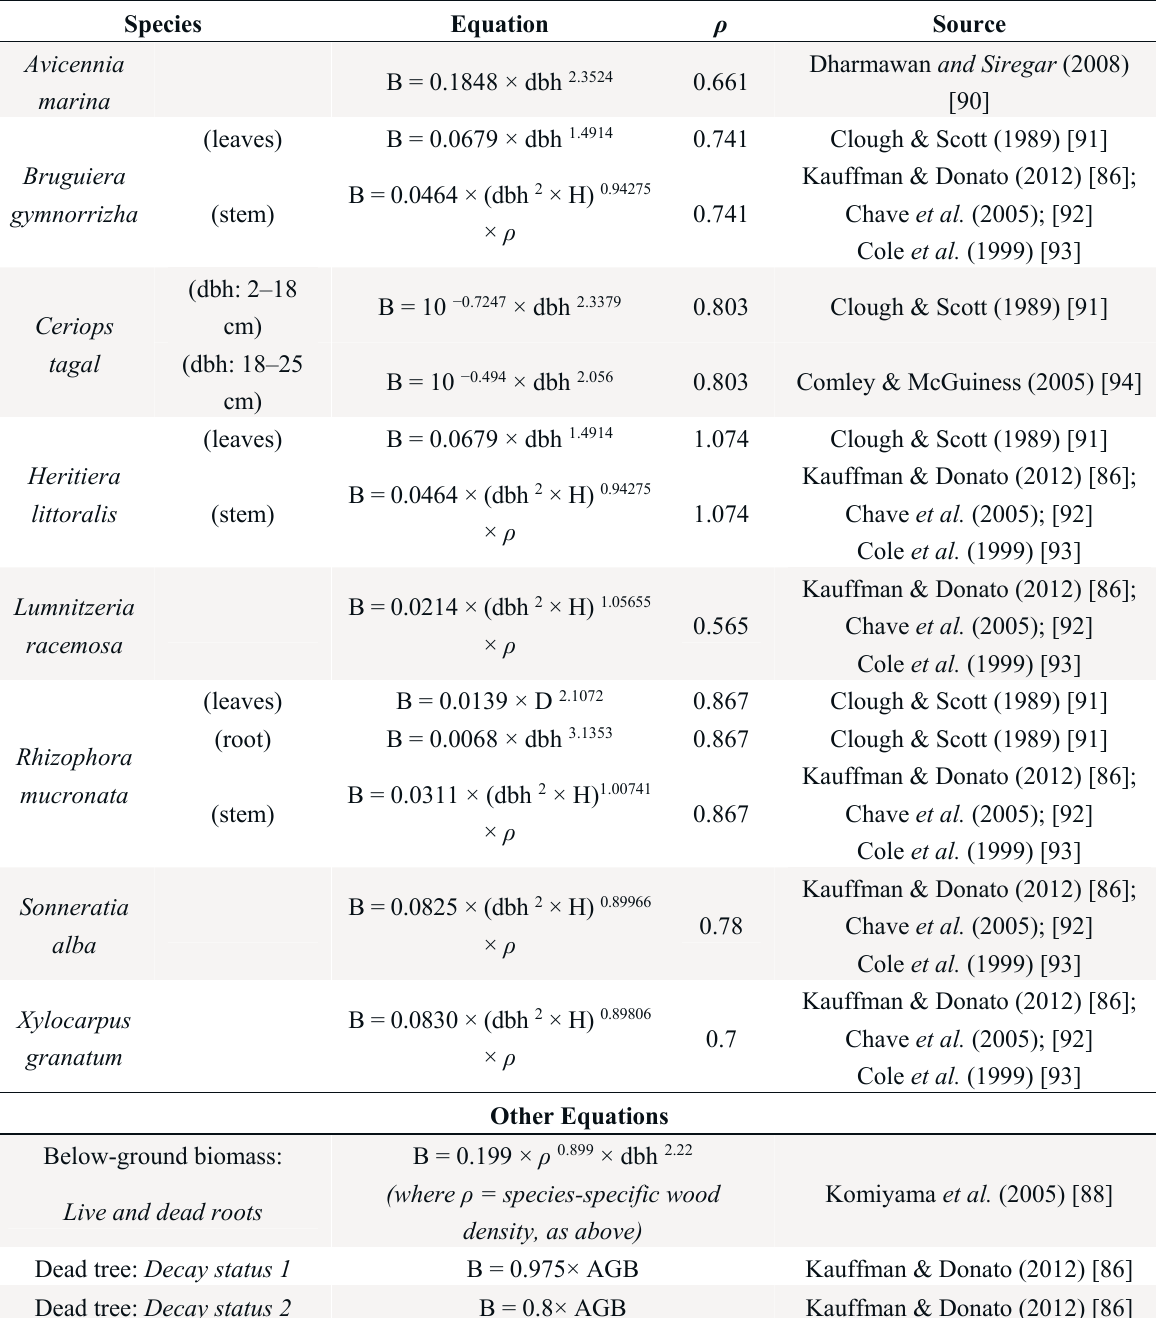
Table 2. Allometric equations employed for calculation of above-ground biomass (B) and additional equations used to estimate below-ground and standing dead wood biomass. Wood density ( ρ ) values are taken from Simpson [89]. H, dbh, and D refer to tree height, diameter at breast height, and diameter,